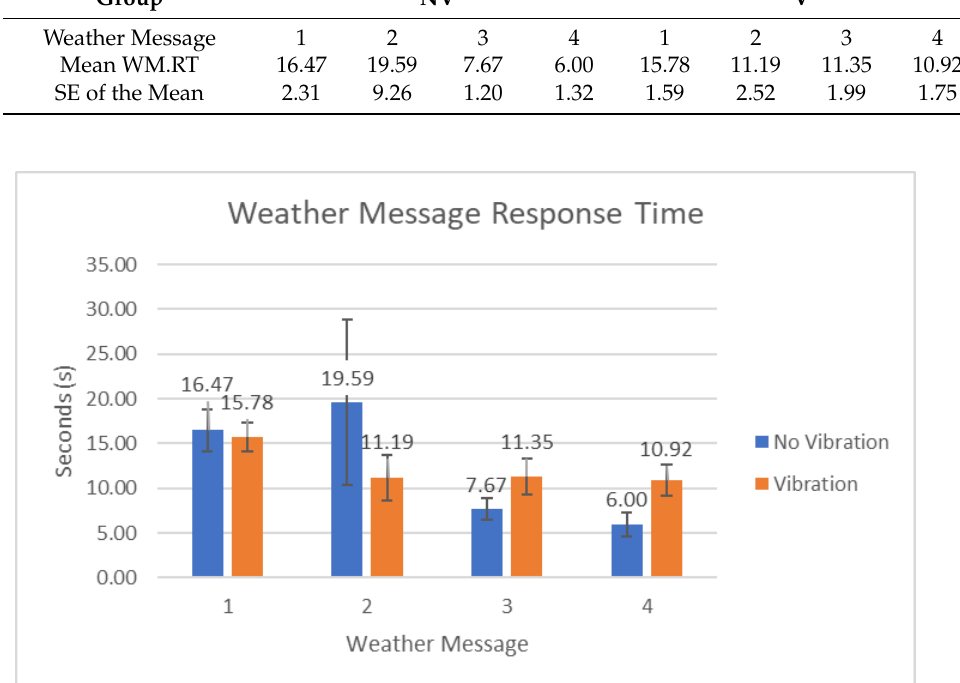
Figure 6. Weather message response time (WM.RT) to the four weather messages (WMs) for each participant group, “No Vibration” (NV) and “Vibration” (V). Bars provide mean values with error bars representing standard error of the mean.